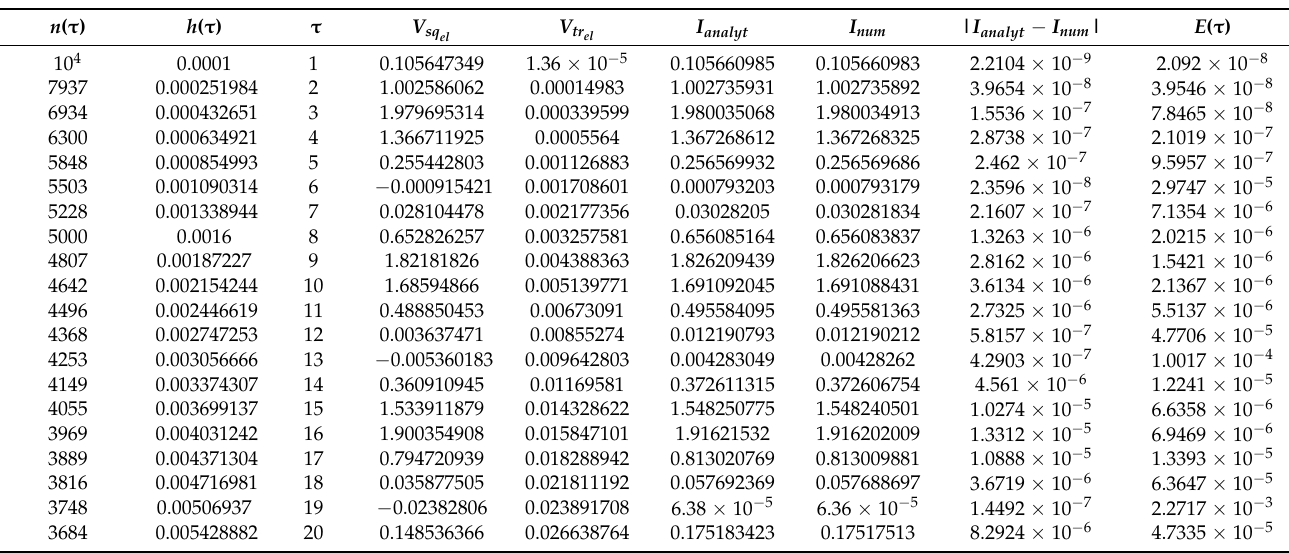
Table 12. Calculation of integral